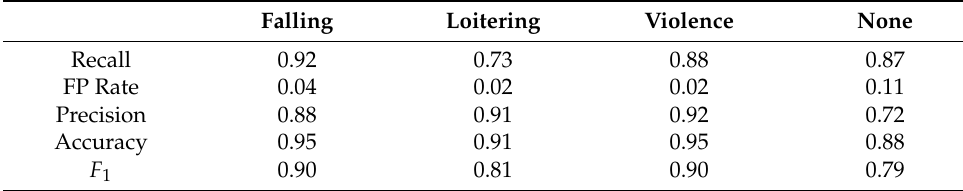
Table 6. Overall classification test results for 4 classes with the basic